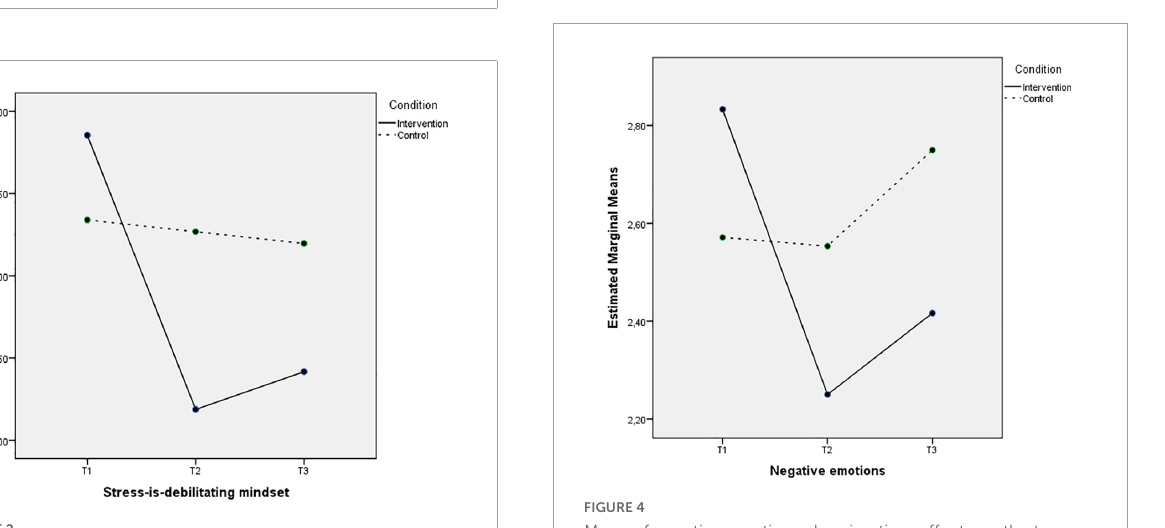
FIGURE2 Mean of SIDM mindset showing time effects for control and intervention groups.